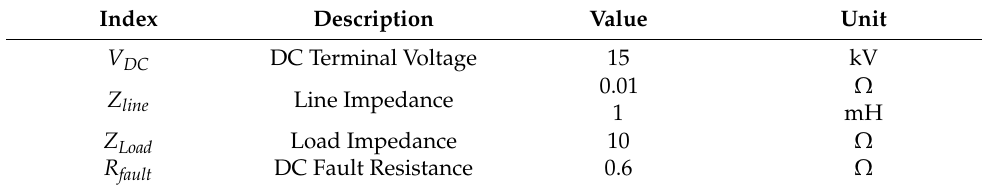
Table 1. Parameters of the DC system for simulation.